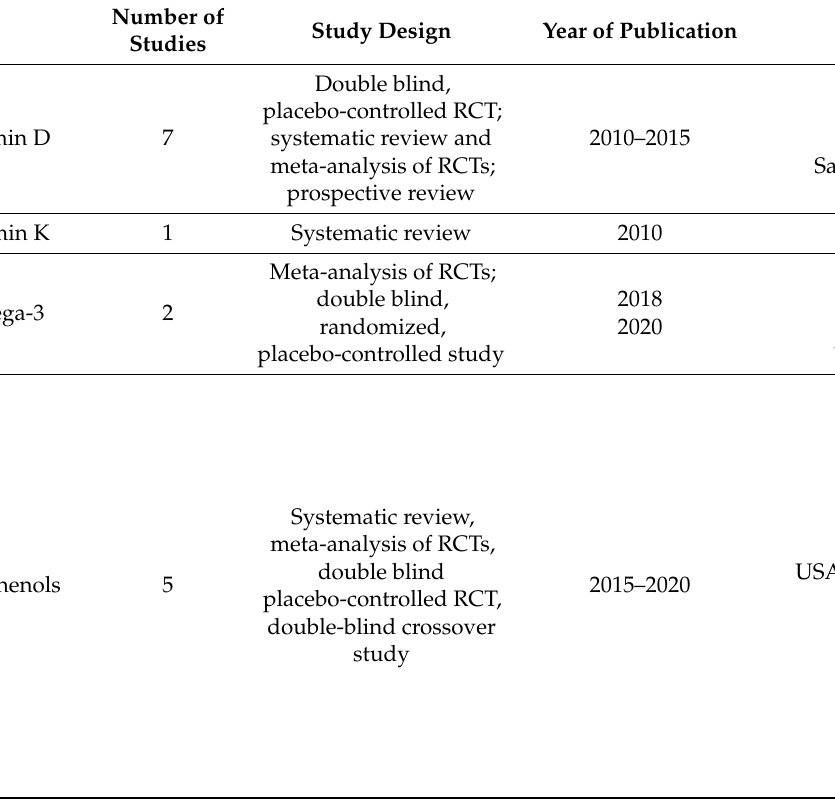
Table 5. Nutraceuticals main